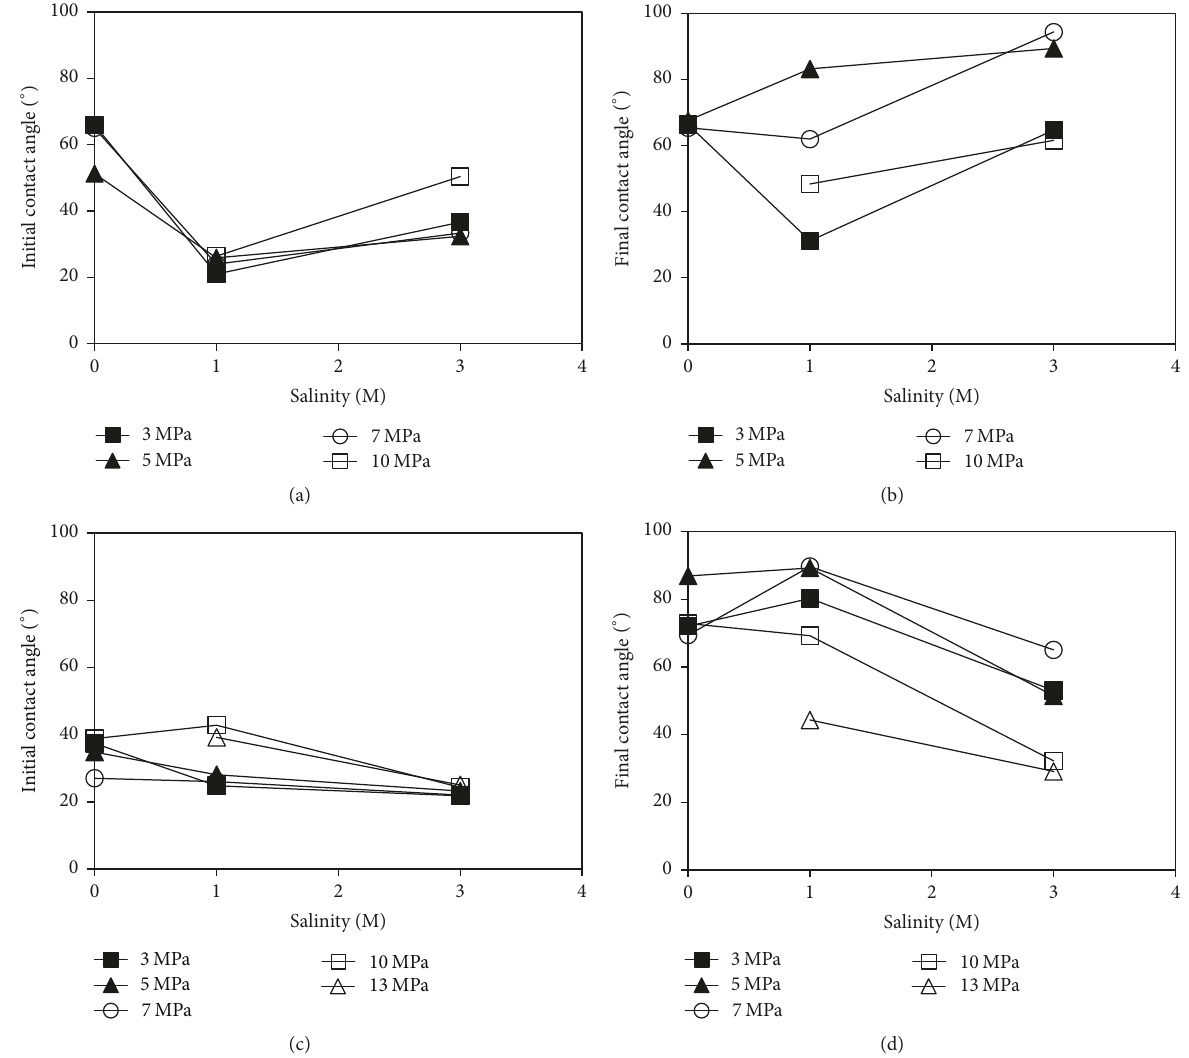
Figure 6: Variations in contact angle with salinity. (a) Initial contact angle on mica V5, (b) final contact angle on mica V5, (c) initial contact angle on mica V1, and (d) final contact angle on mica